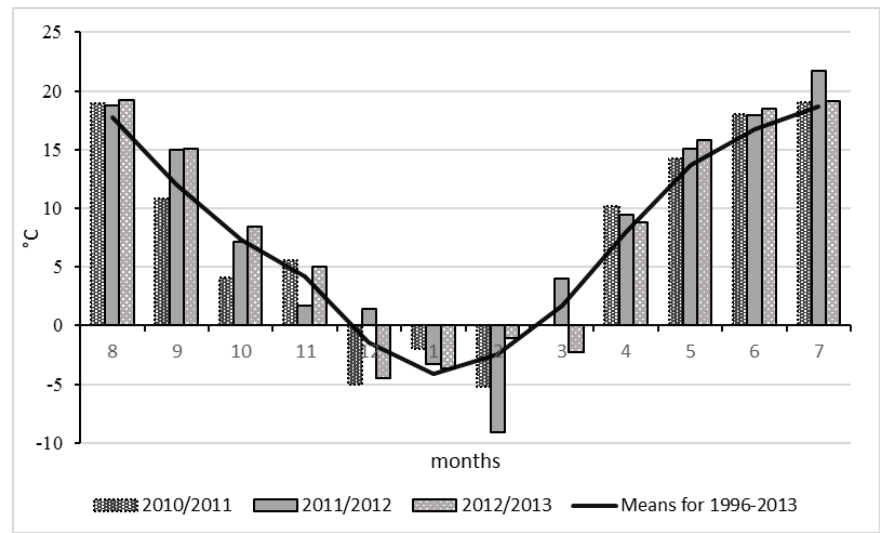
Figure 1. Rainfall in months (according to the COBORU Meteorological Station in Ulhówek) as com- pared to the long - term means (according to the meteorological station in Tomaszów Lubelski, Insti- tute of Meteorology and Water Management — National Research Institute in Warsaw Meteorolog- ical Station).